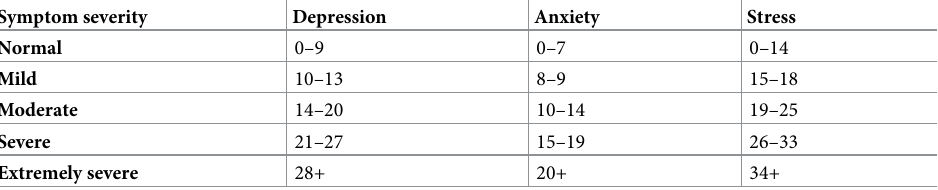
Table 1. Depression anxiety stress scale (DASS 21)